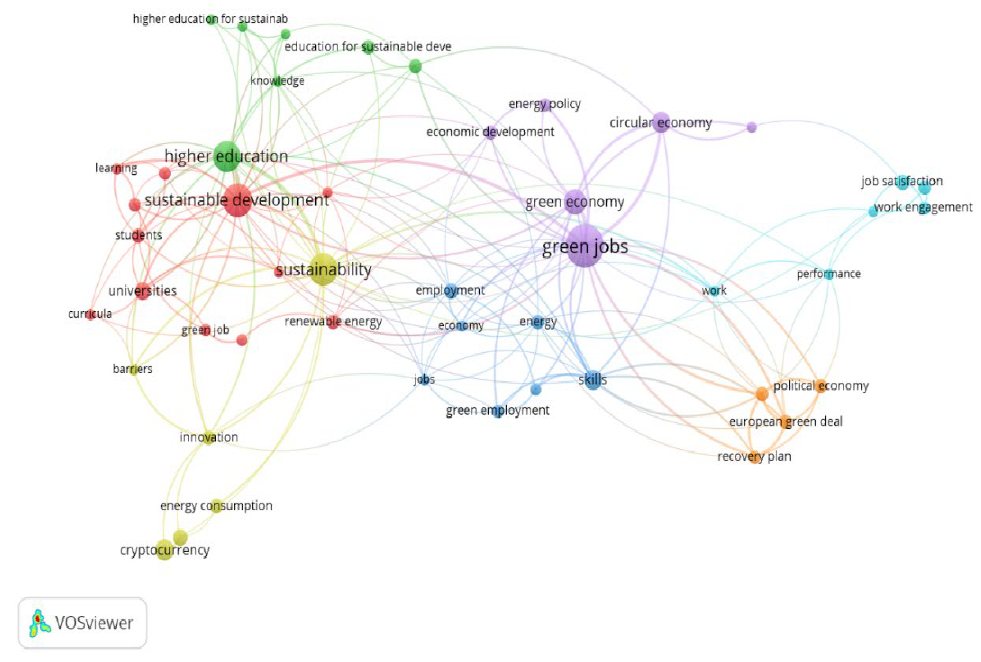
Figure 1. Network of key term associations.